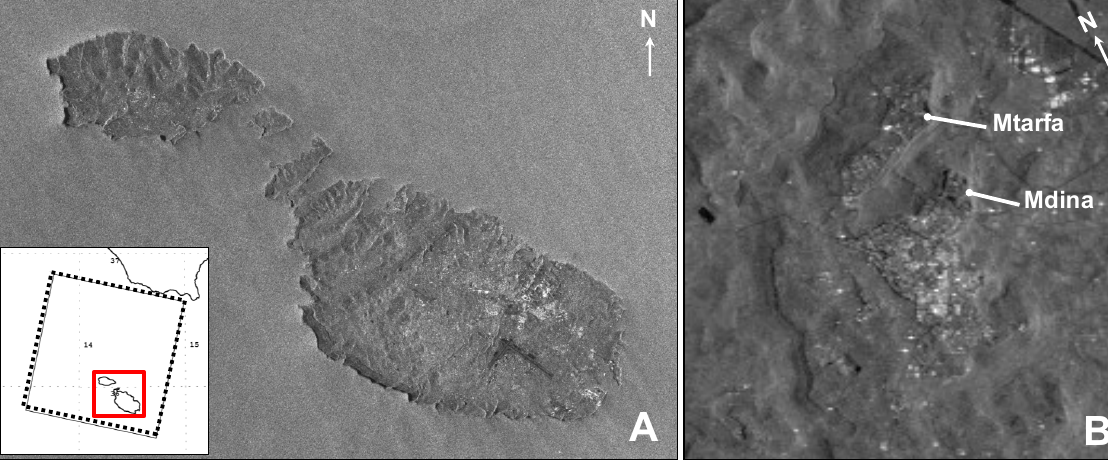
Fig. 10. (A) : Example of ERS2 image acquired along descending orbit on the Maltese Archipelago (displayed in terms of amplitude). Footprint of the whole scene is shown within the inset as a dashed black polygon. (B) : Subset of (A) displayed in SAR coordinates and including the urban area of Mtarfa and